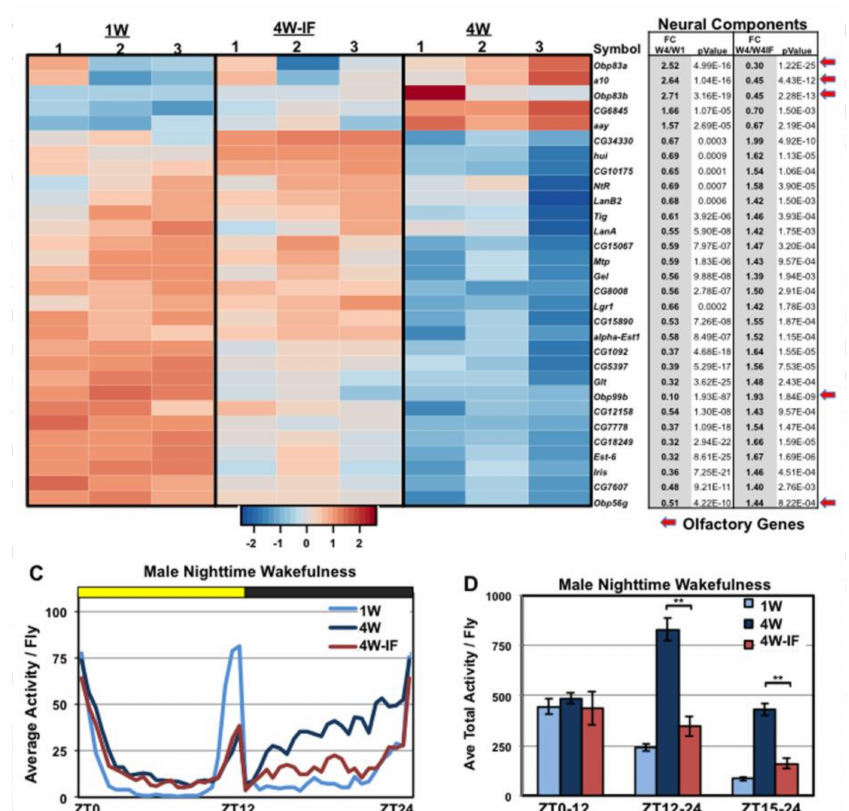
Figure 3. Age and IF-dependent expression changes to adult neuronal pathway components and adult olfactory-based behaviors. DAVID analysis identified genes with neuronal functions that demonstrated age and IF-dependent fluctuations in expression levels. ( A ) Heatmap and corresponding table represents hierarchical clustering of scaled gene expression profiles and fold change (FC) and p values between 4W/1W and 4W/4W-IF RNA-seq cohorts. Scaled expression values (Z-score) of RPKM expression levels were plotted in red (high) versus blue (low) color scale. Arrows indicate olfactory binding genes that are linked to behavioral defects. ( B , C ) Average 24 h activity profiles of grouped housed 1W, 4W and 4W IF male fly cohorts ( n = 16 groups of 10 flies) and ( D ) Activity levels during light (ZT0 to 12) dark (ZT12 to 24) and mid-dark (ZT15 to 24) time periods. ** p ≤